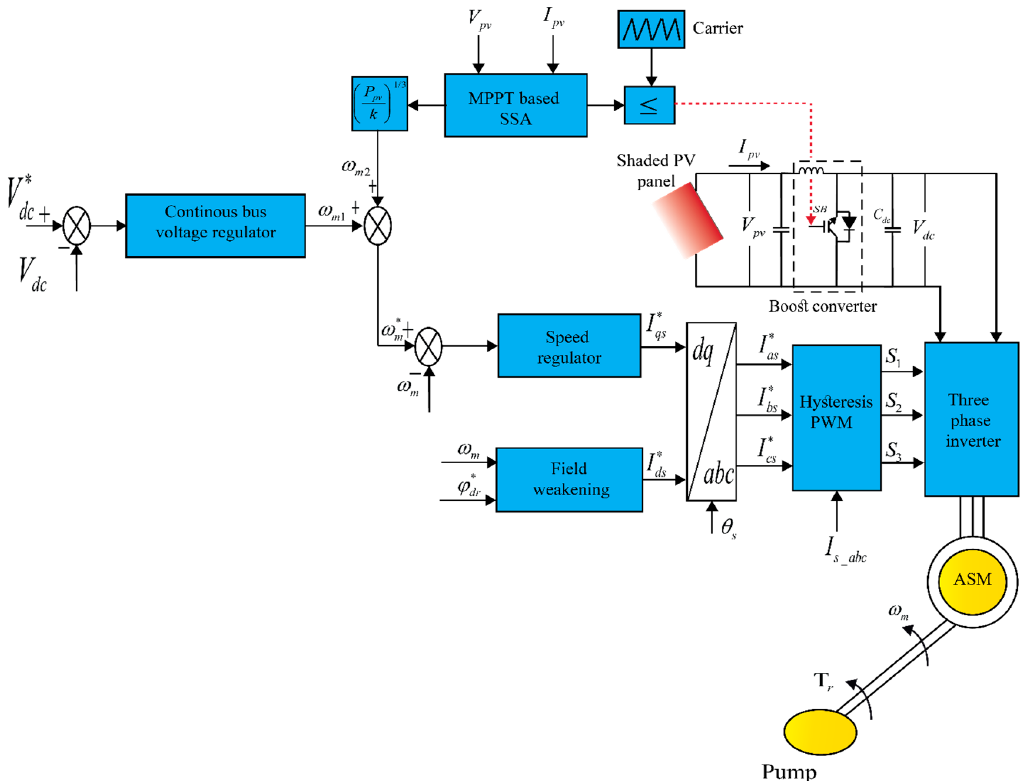
Figure 1. Scheme diagram of the proposed system.